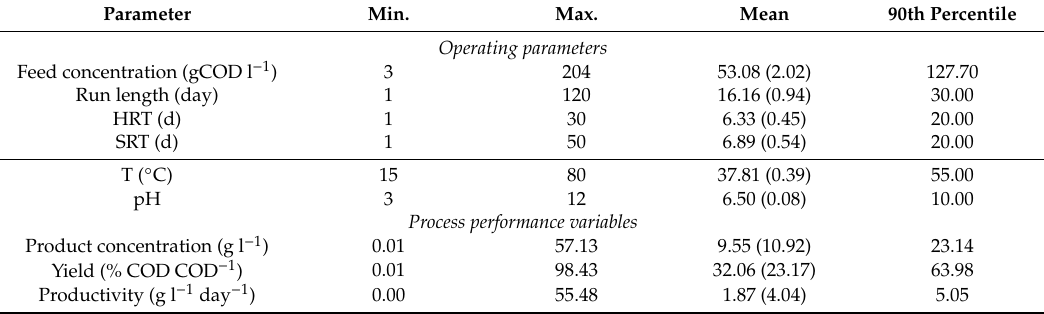
Table 3. Minimum value, maximum value, mean with standard error (in bracket), 90th percentile of the considered operating parameters, and process performance variables in the literature